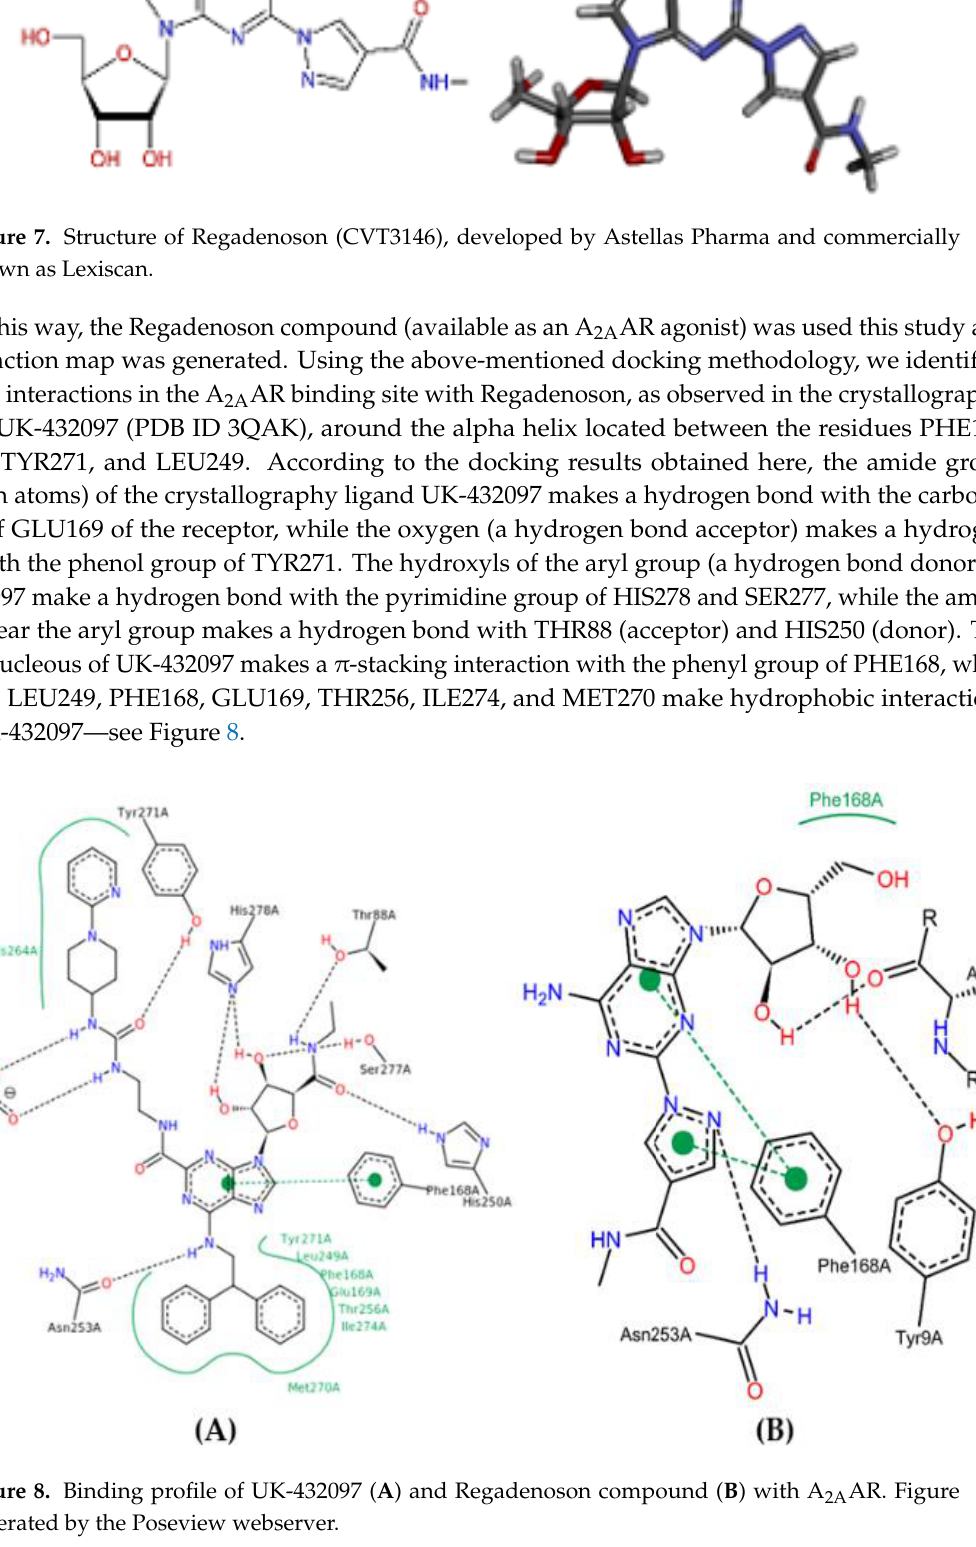
generated by the Poseview webserver.